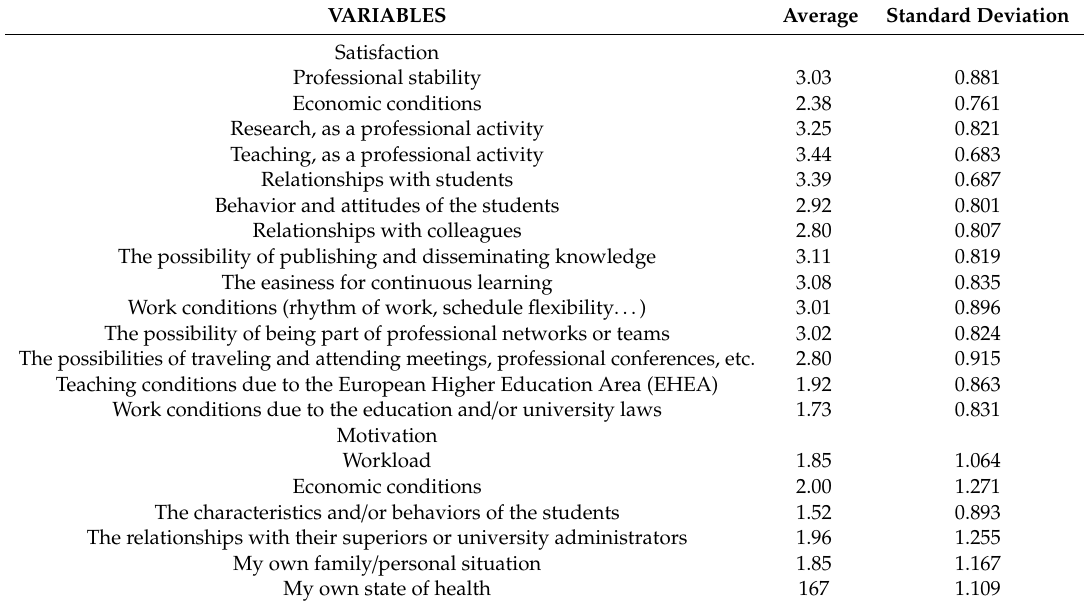
Table 1. Descriptive analysis of the main variables studied in the sample (minimum 1; maximum